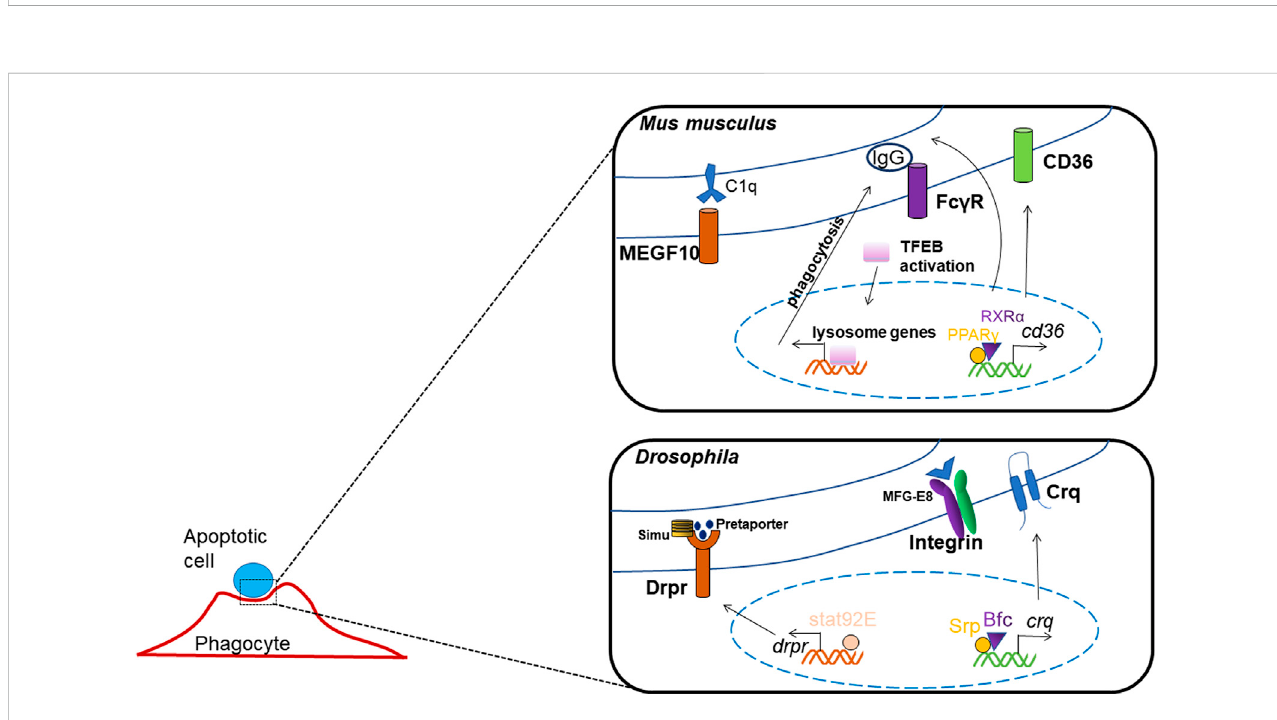
FIGURE 4 Transcription factors regulating apoptotic cell